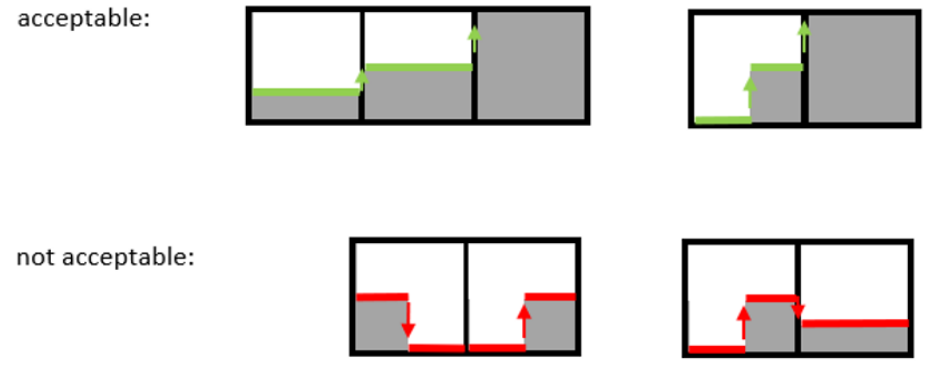
Figure 5. Clear space forming requirement of office blocks, interior space organization.